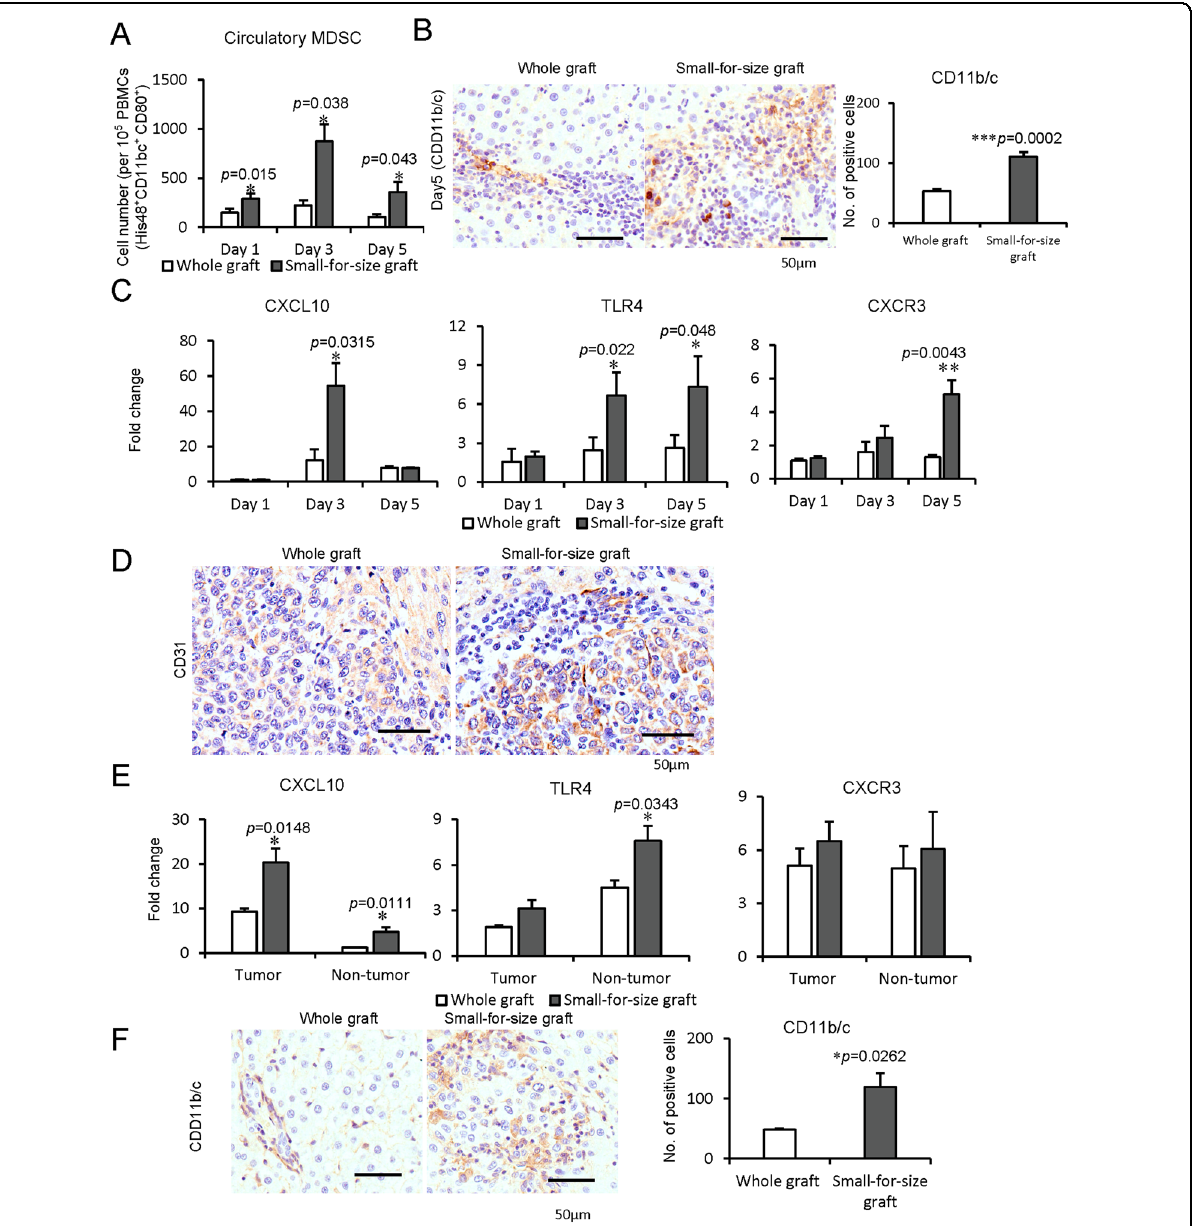
Fig. 3 Association among MDSC mobilization, CXCL10/TLR4 expressions, and liver tumor recurrence in rat orthotopic liver transplantation models. A – C Rat orthotopic liver transplantation model. A More circulatory MDSCs in rats at Day 1, 3, 5 after small-for-size graft transplantation in contrast with whole graft. B Increased intragraft MDSCs (CD11b/c positive) in rats with small-for-size grafts at Day 5. C Increased intragraft mRNA expressions of CXCL10 (Day 3), TLR4 (Day 3, 5), CXCR3 (Day 5) in small-for-size liver graft. D – F Rat orthotopic liver transplantation with tumor recurrence model. D Higher MVD in the tumors from a small-for-size liver graft on Day 14 after transplantation. E Higher expressions of CXCL10 (both in tumor and non-tumor tissue) and TLR4 (in non-tumor tissue) in small-for-size liver graft with tumor recurrence. F More in fi ltrated MDSCs in small- for-size liver graft with tumor recurrence. N = 5/group; Scale bars: 50 μ m; error bars indicate standard error of mean; *p < 0.05, ** p < 0.01, ***p < 0.001. MDSC myeloid-derived suppressor cell, MVD microvessel